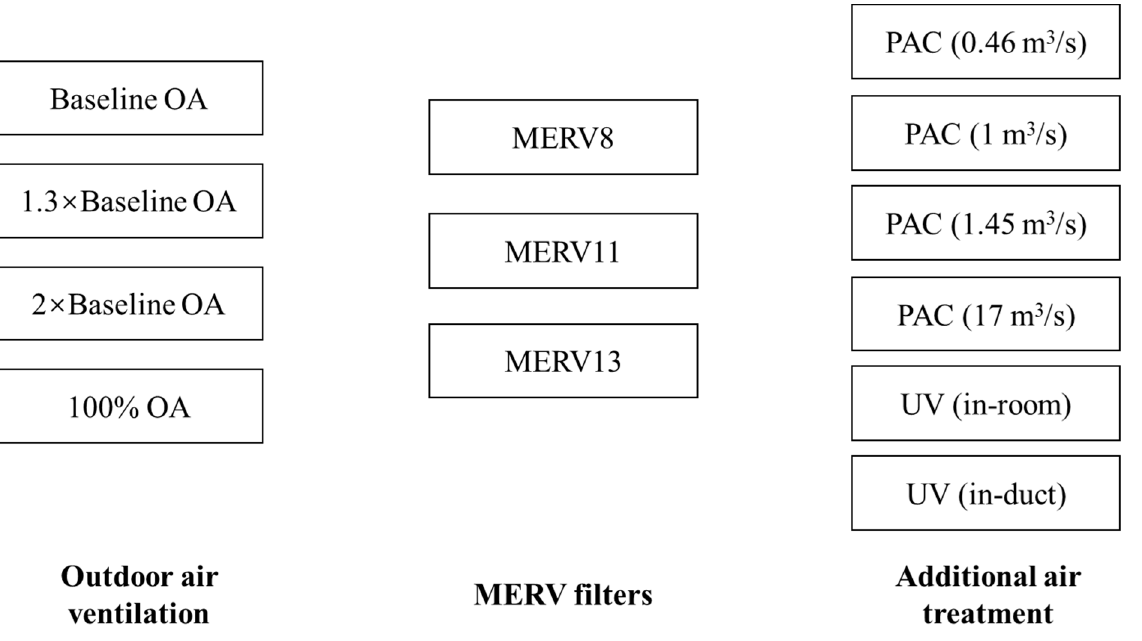
Figure 4. Seventy-two combinations of mitigations evaluated in this study. Table 2. SARS-CoV-2 Quanta-Related Modeling